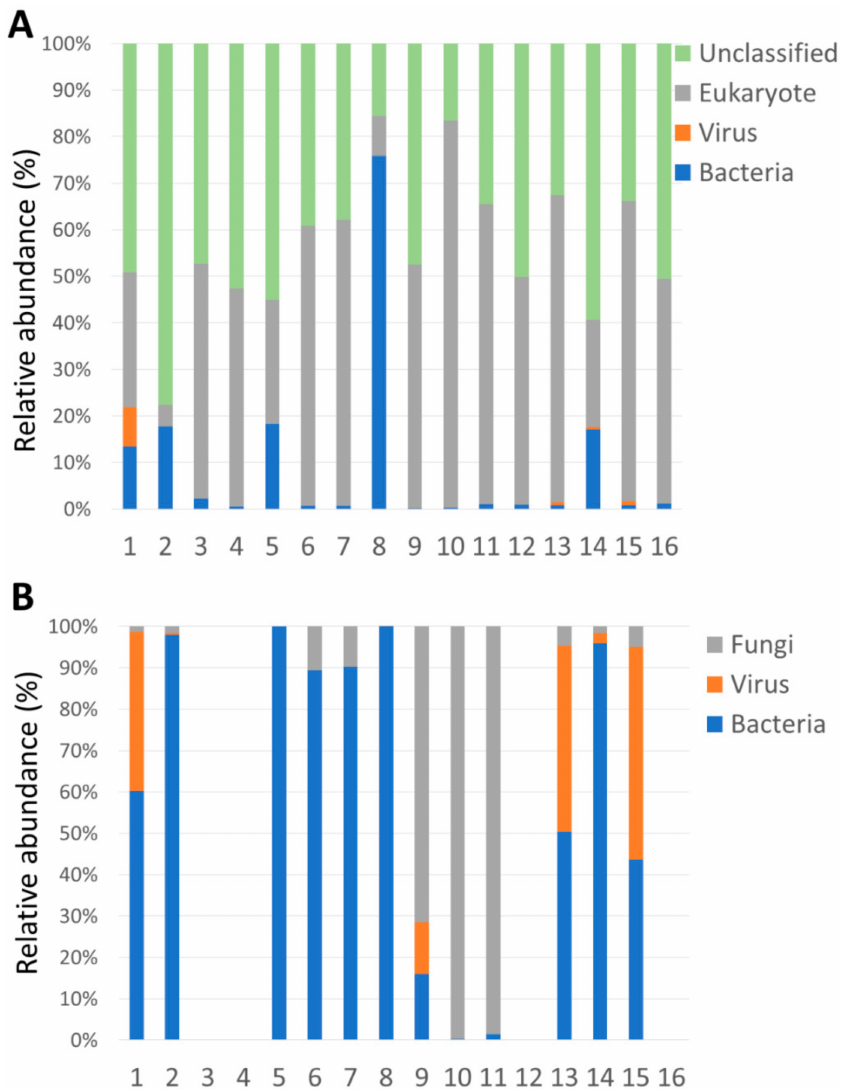
Figure 2. Rate of reads in specimens ( A ) Reads after genomic subtraction of human genome ( B ) Reads after genomic subtraction of unclassified and eukaryotic